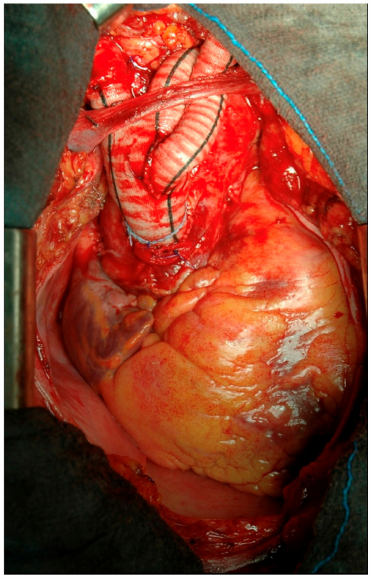
Figure 1. Type I aortic arch debranching.